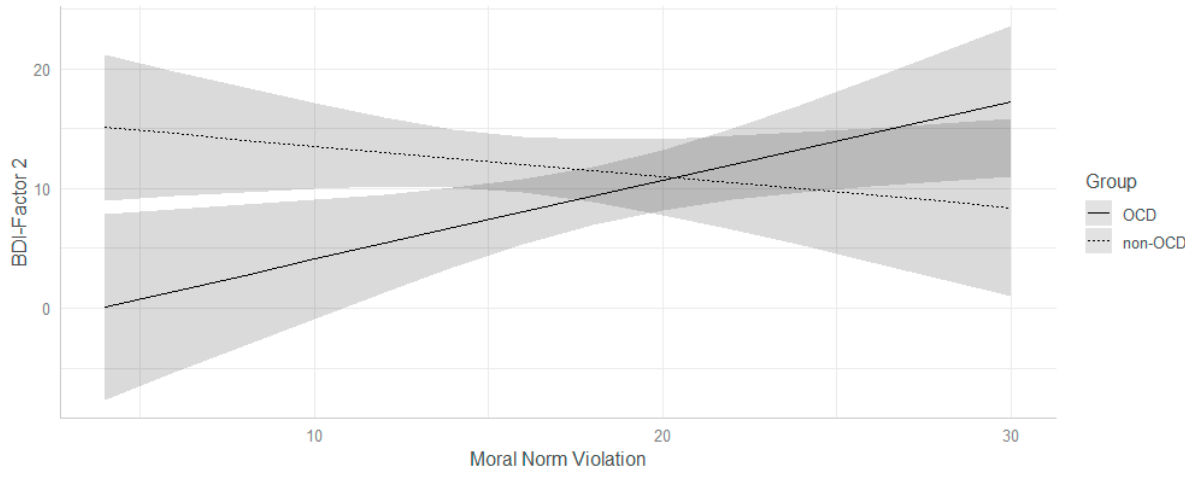
Figure 2. Moral Violation Norm × group interaction on factor 2 scores of BDI. Grey areas represent confidence intervals. BDI= Beck Depression Inventory.